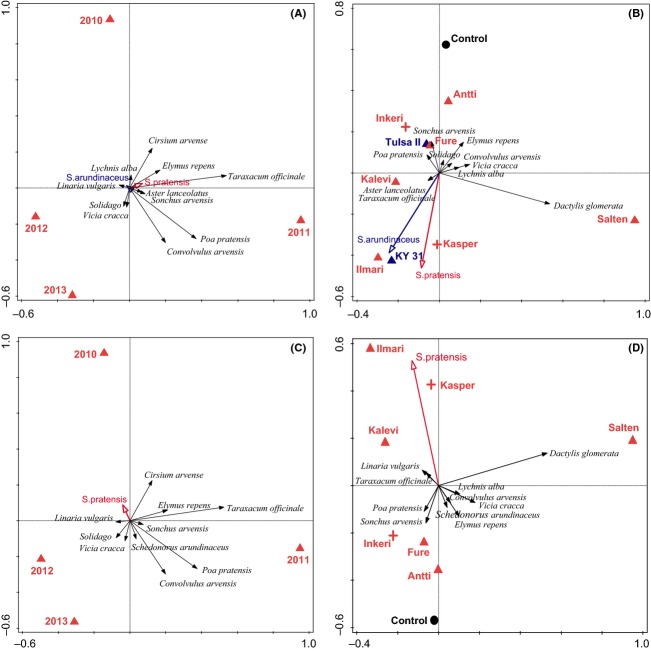
Biplots based on partial redundancy analyses of the vegetation composition with respect to the effect of year (A,C) and Schedonorus cultivar (B,D) treatment. (A,B) All cultivars, the 10 best fitting of 13 plant species are displayed. (C,D) S. pratensis cultivars, the 10 best fitting of 12 plant species are displayed. Blue = S. arundinaceus cultivars, red = S. pratensis cultivars, triangle = low-endophyte frequency (E−), + = high-endophyte frequency (E+).